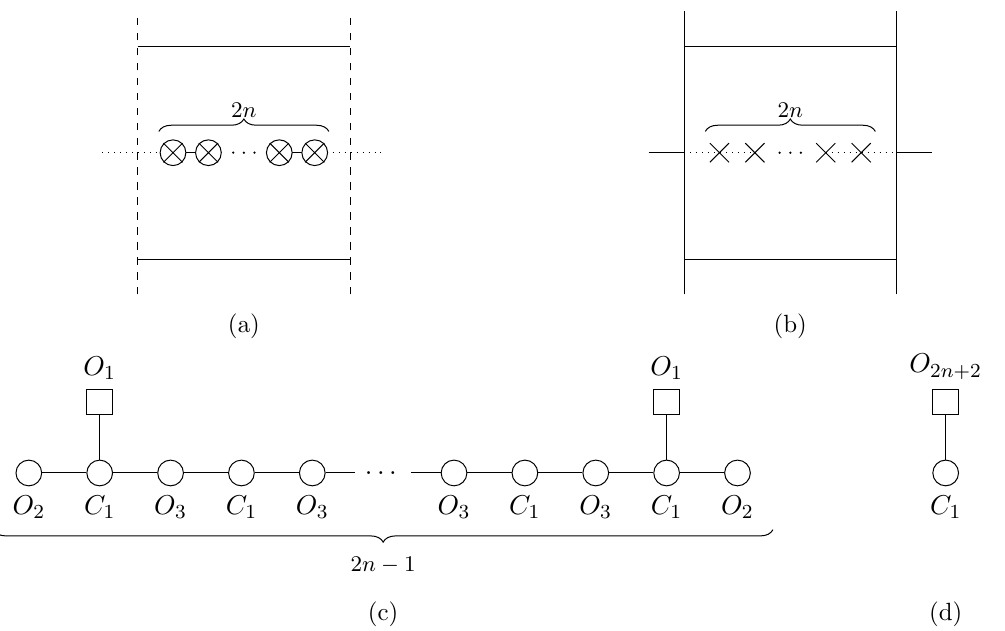
Figure 53. D n +1 subregular singularity. (a) Brane subsystem that represents the moduli space generated by a single D3-brane in the leftmost interval of (cid:12)gure 52. (b) After S-duality the moduli space generated by this single D3-brane as a Coulomb branch. (c) Quiver corresponding to brane system (a), its Higgs branch is M H = D n +1 . (d) Quiver corresponding to brane system (b), its Coulomb branch is M C = D n +1 . These quivers are identical to the ones found in (cid:12)gure